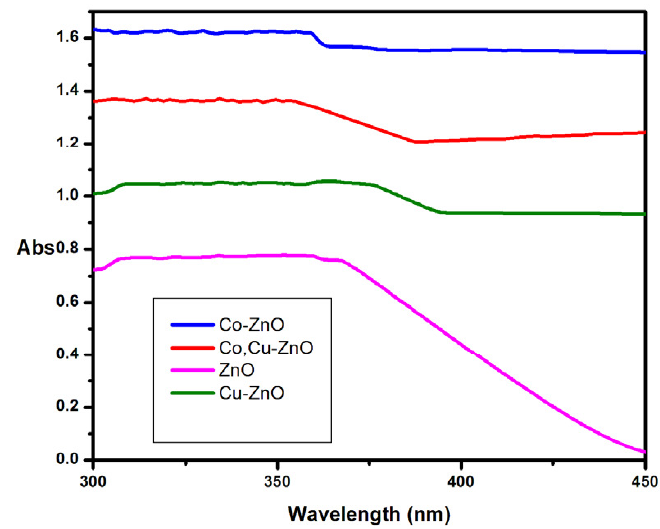
Fig. 1. UV- DRS spectrum of Co and Cu codoped ZnO